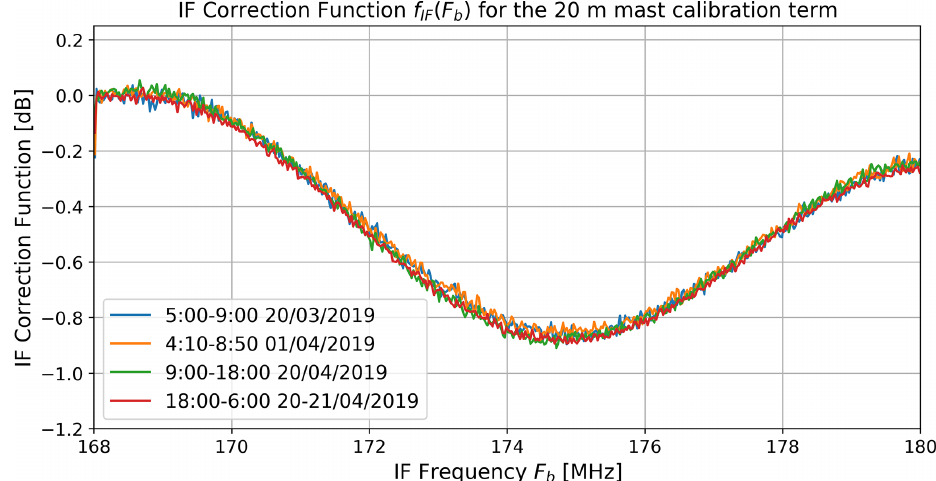
Figure 8. Data used for the IF correction function calculation, retrieved for different periods of the 2019 calibration campaign. The 2018 IF correction function is different from the 2019 results because the hardware was modified between the campaigns (see 2018 IF correction function presented in Sect. 6). The time indicated in the label is in universal coordinated time